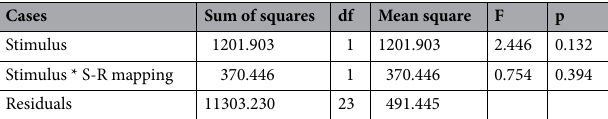
Table 2. Within subjects effects on response times.